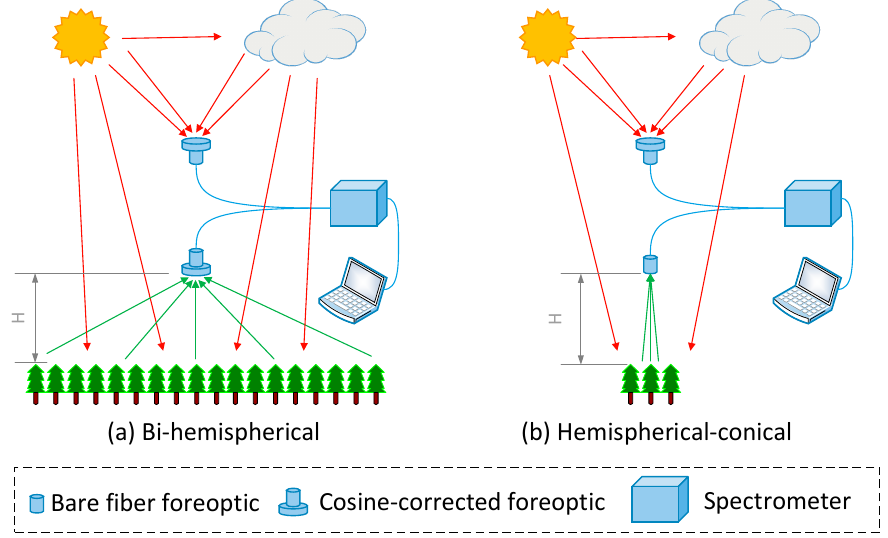
Figure 1. Illustration of the bi-hemispherical and hemispherical-conical configurations of in situ spectral measurements.